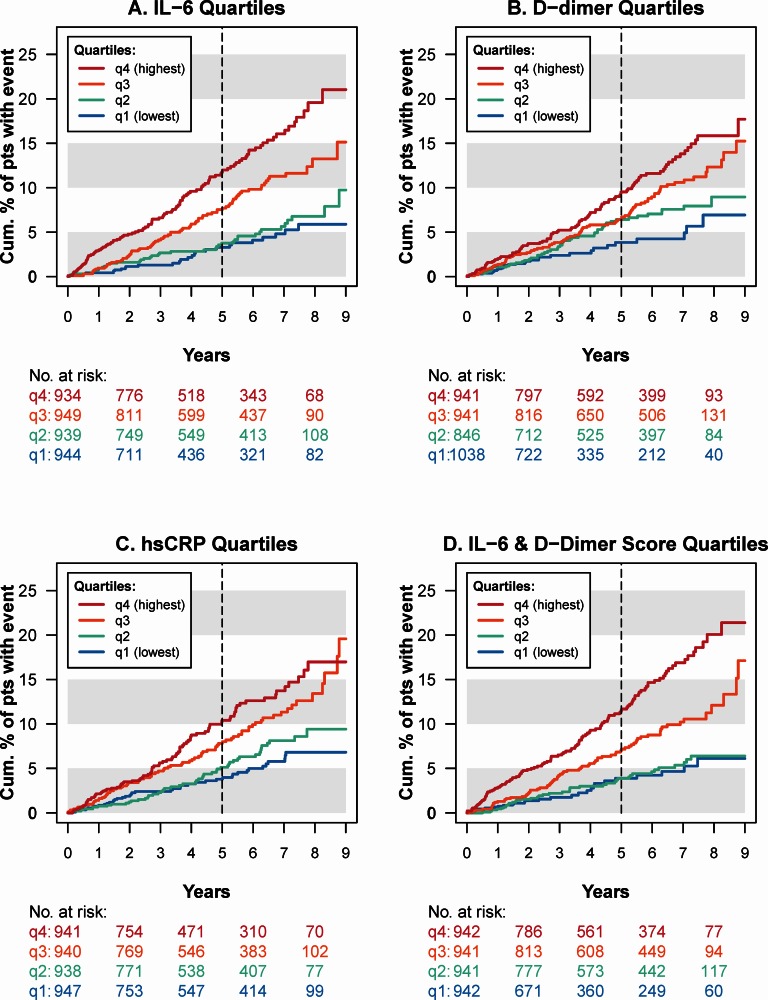
Kaplan-Meier estimates of the cumulative proportion of participants who experienced serious non-AIDS disease or death (SNA/death), by quartiles of IL-6 (A), D-dimer (B), hsCRP (C), and the IL-6 & D-dimer score (D). Biomarkers were measured at study entry. At 5 years, the risk of SNA/death was 12.0% for participants in the highest quartile of IL-6, compared with 3.5% for participants in the two lowest quartiles. Abbreviations: IL-6 = Interleukin-6; hsCRP = high-sensitivity C-reactive protein.